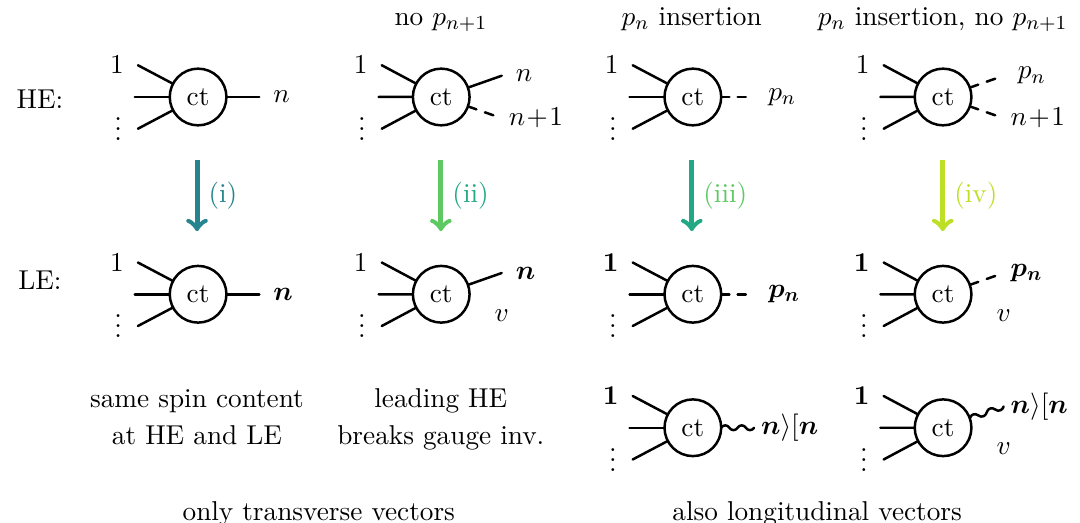
Figure 3 . Massive low-energy (LE) contact terms are obtained from the little-group covarianti- zation of the massless high-energy (HE) contact terms corresponding to their leading components. In the simplest case, this simply amounts to bolding massless spinors into massive ones ((i)). An additional soft Higgs leg is required to produce massive LE contact terms whose leading high-energy component is a massless HE amplitude that breaks gauge invariance ((ii) and (iv)). Massless HE amplitudes featuring a scalar momentum insertion are required to generate massive longitudinal vectors at LE ((iii) and